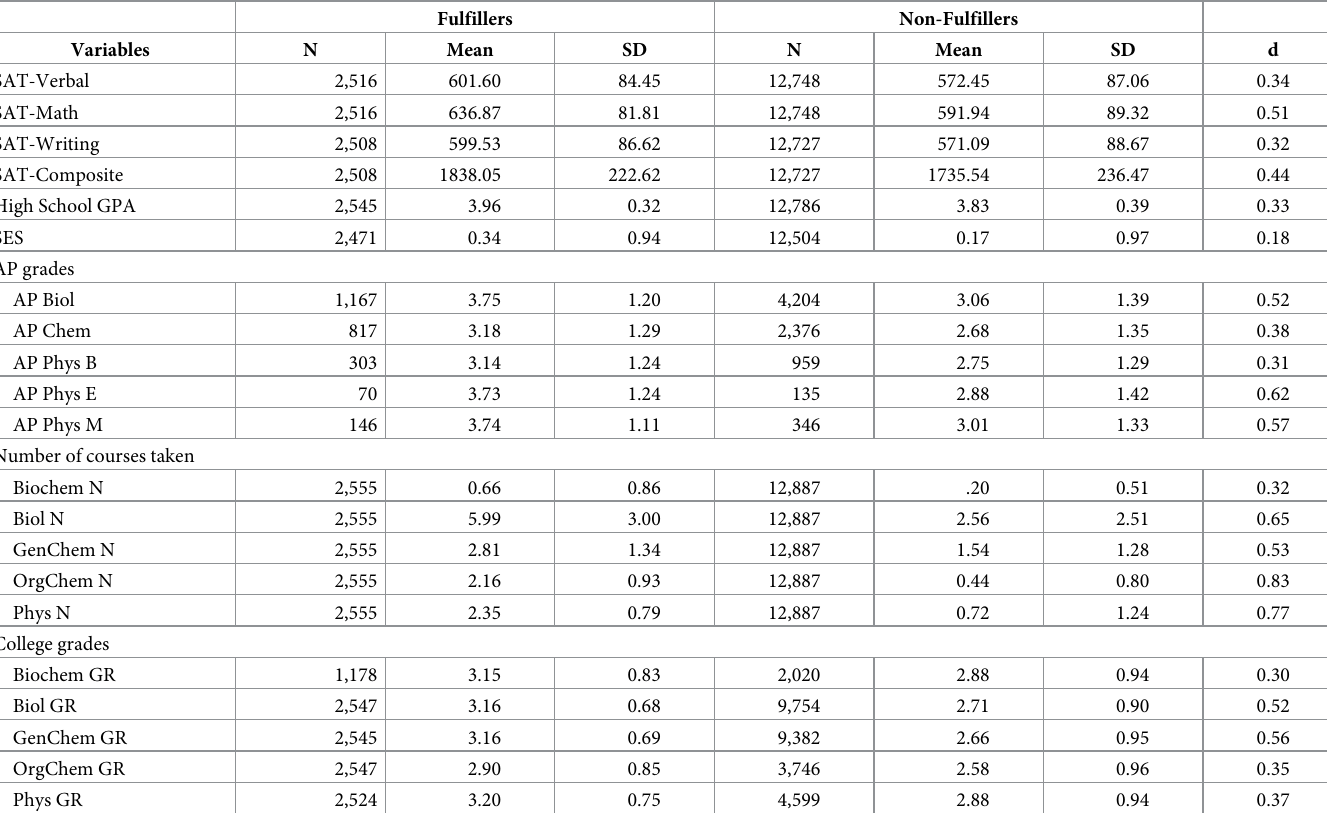
Table 2. Mean (SD) for continuous variables for fulfillers and non-fulfillers: